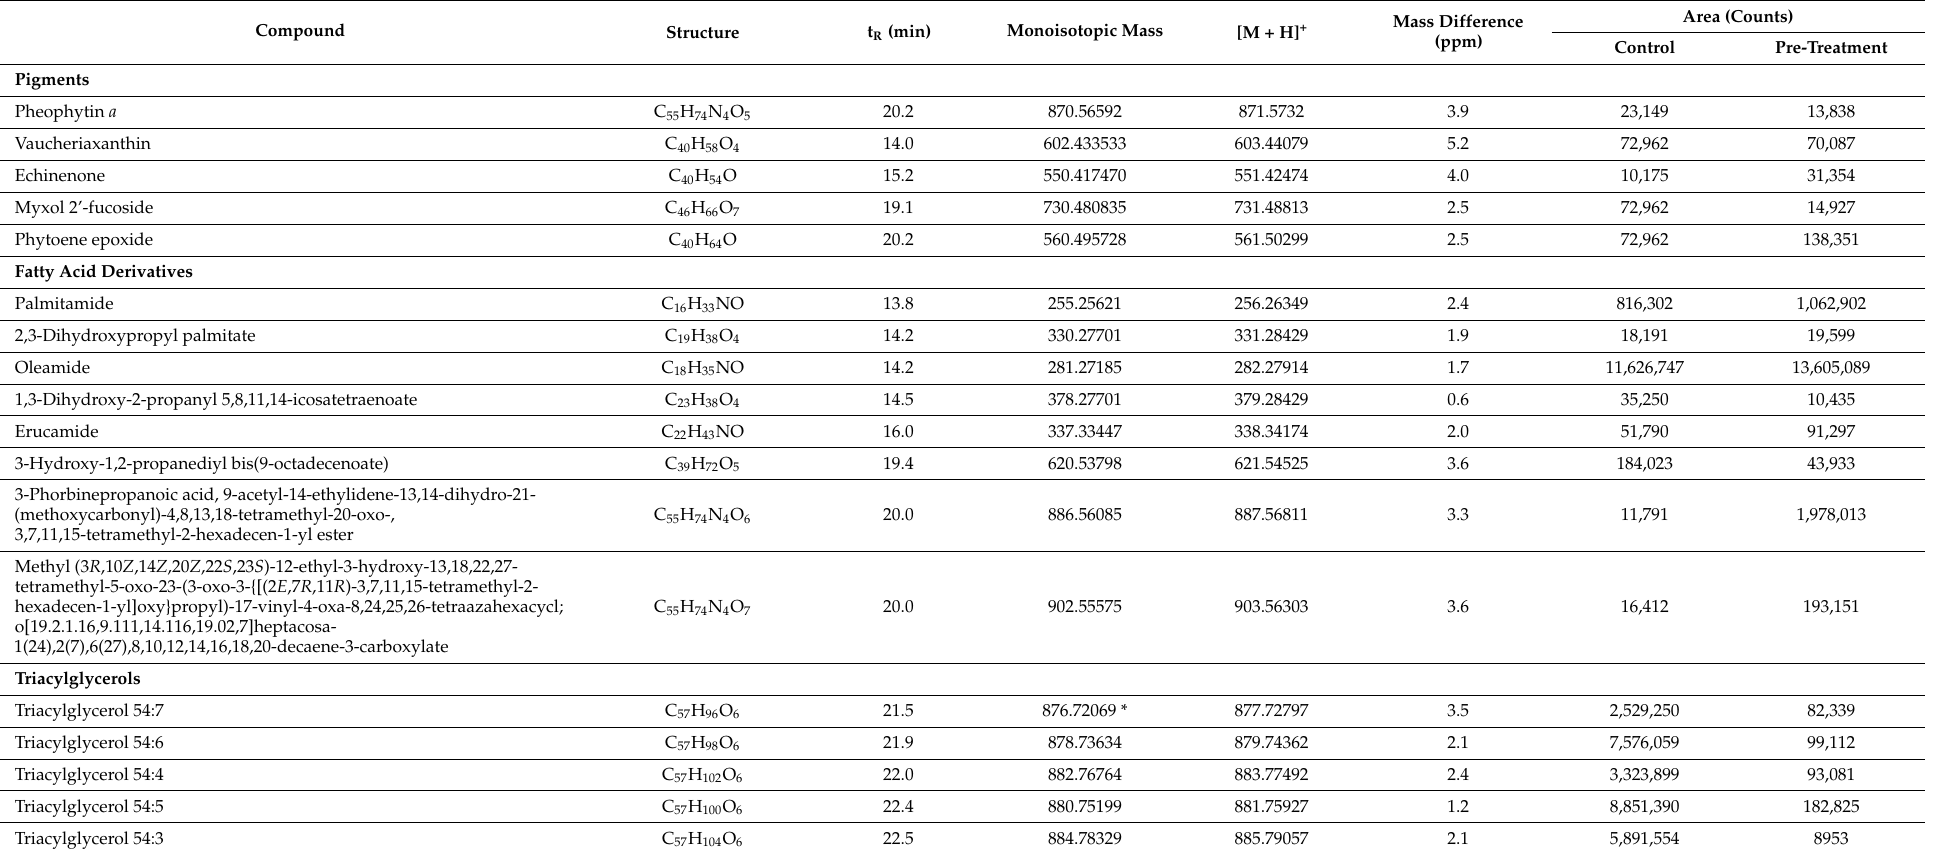
Table 1. Chemical profile of supercritical CO 2 extracts (control and pre-treated) of Tetradesmus obliquus